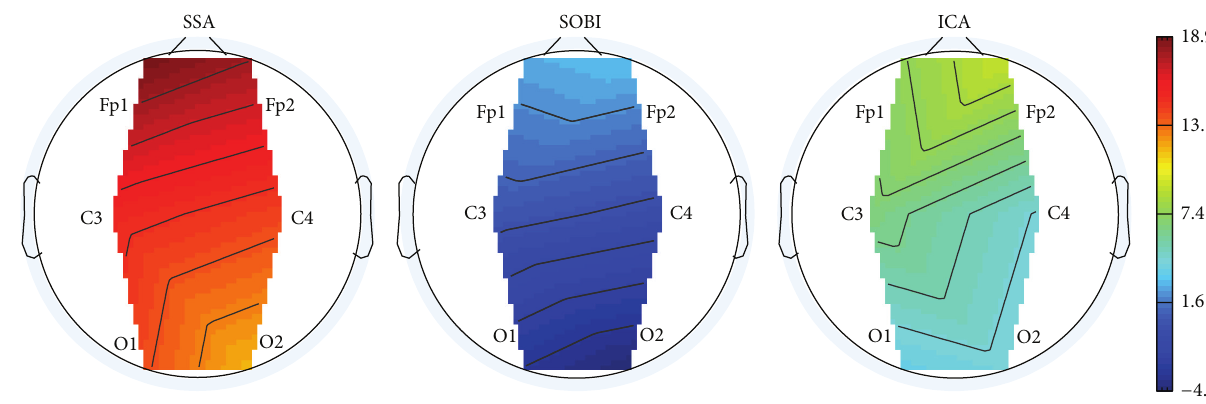
Figure 4: Topographic map showing improvements of SAR after applying the ocular artifact correction procedure.